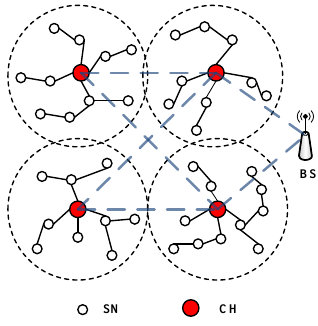
Figure 1. Clustered wireless sensor networks (WSN) architecture. (SN = sensor node, CH = cluster head, BS = base station).